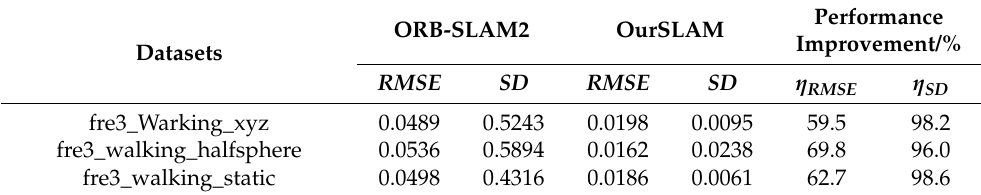
Table 2. Comparison results of relative positional error